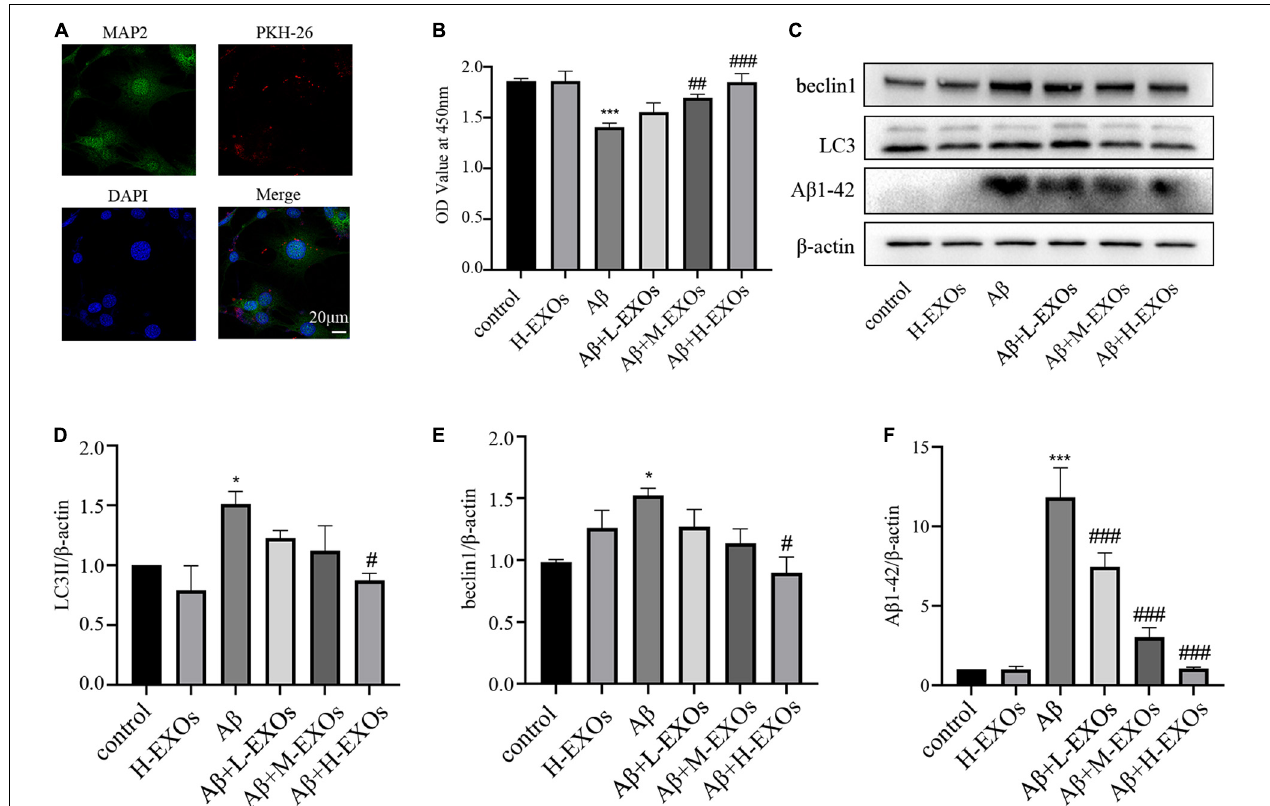
FIGURE 4 | M2-EXOs attenuate the cell impairment caused by A β in a dose-dependent way. (A) Images of PKH-26-labeled exosomes (red) and neurons (green) after the 24-hour co-culture observed by confocal microscopy. (B) The cell viability of HT-22 cells co-cultured with different concentrations of M2-EXOs determined by CCK-8. (C) The expressions of LC3II,beclin1 and A β 1-42 detected by Western blot analysis. (D) Quantification of LC3II expression. (E) Quantification of beclin1 expression. (F) Quantification of A β 1-42 expression. All experiments were repeated three times. # P < 0.05 vs. A β , ## P < 0.01 vs. A β , ### P < 0.001 vs. A β , * P < 0.05 vs. control, *** P < 0.001 vs.